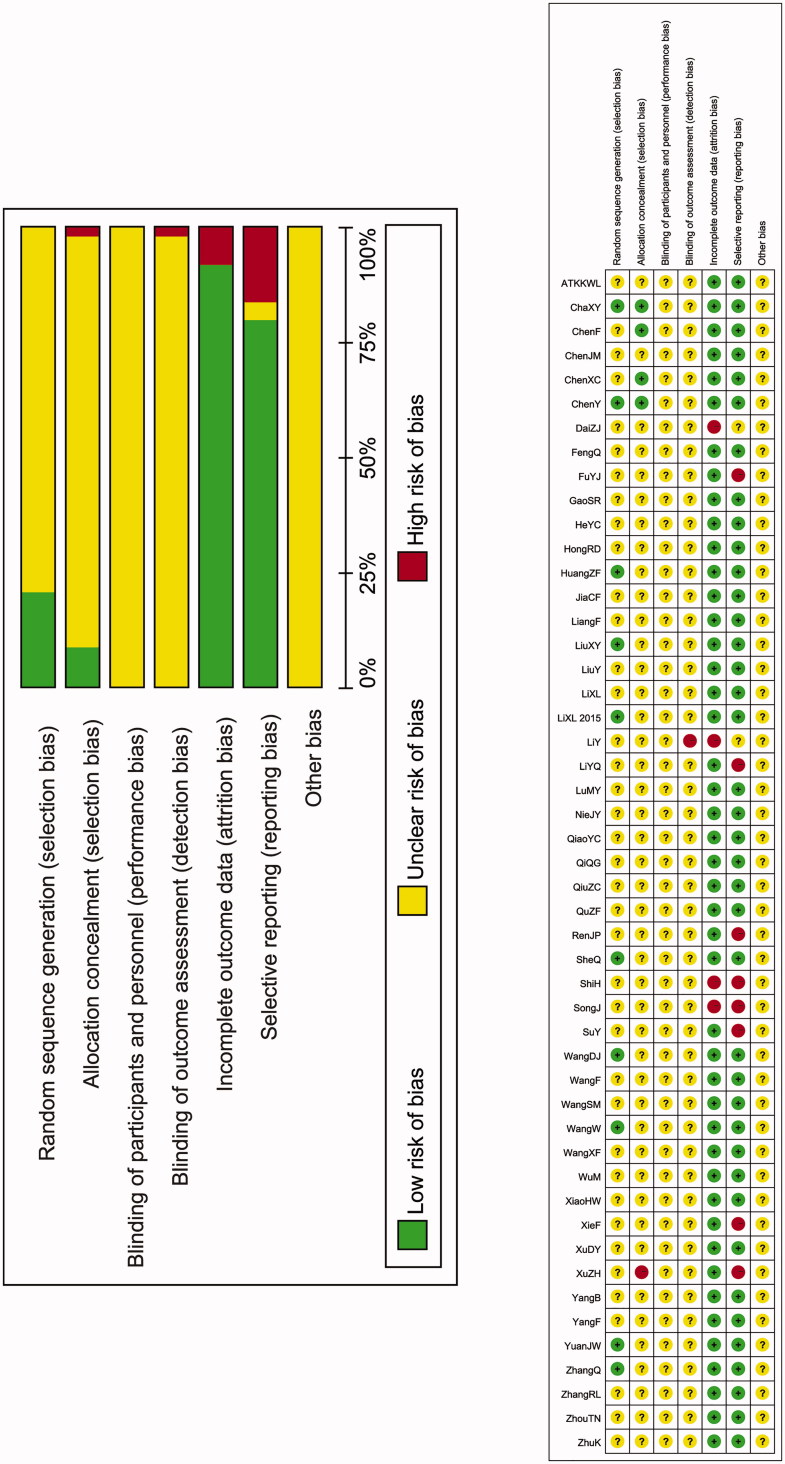
Risk of bias summary of 49 included studies.